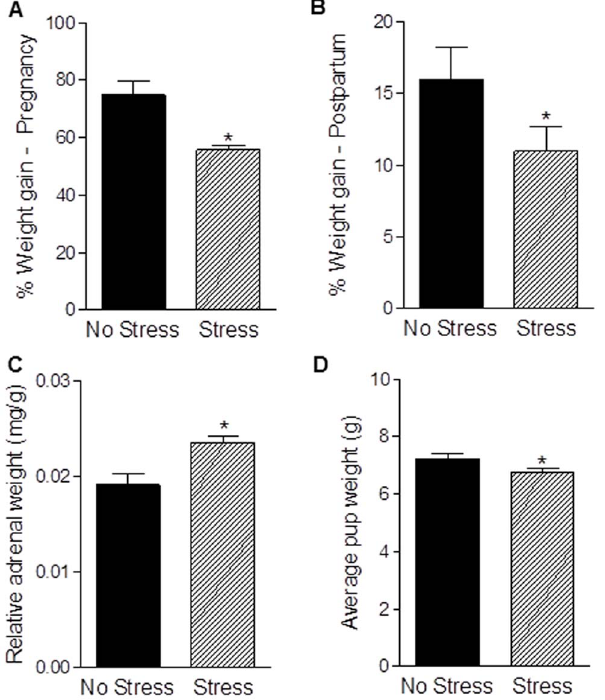
Figure 1. Effects of gestational stress on physiological parameters of mothers and pups. Exposure to chronic stress during pregnancy decreased gestational (a) and postpartum (b) weight gain but increased relative adrenal weight (c). Gestational stress also led to a reduction in average pup weight at birth (d). Bars represent mean 6 SEM, * p ,